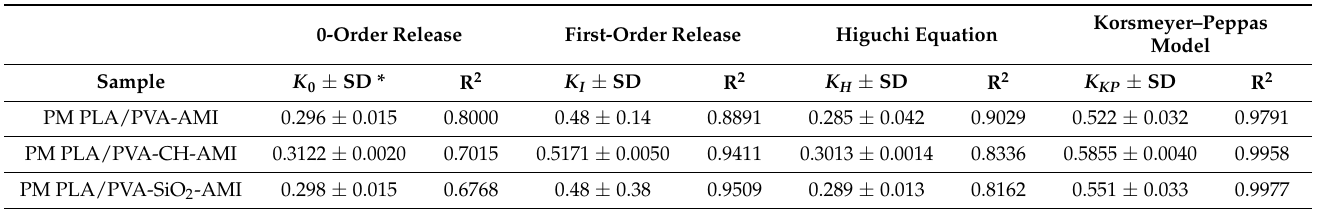
Table 6. Release constants ( K ) and correlation coefficients (R 2 ) determined by mathematical models.